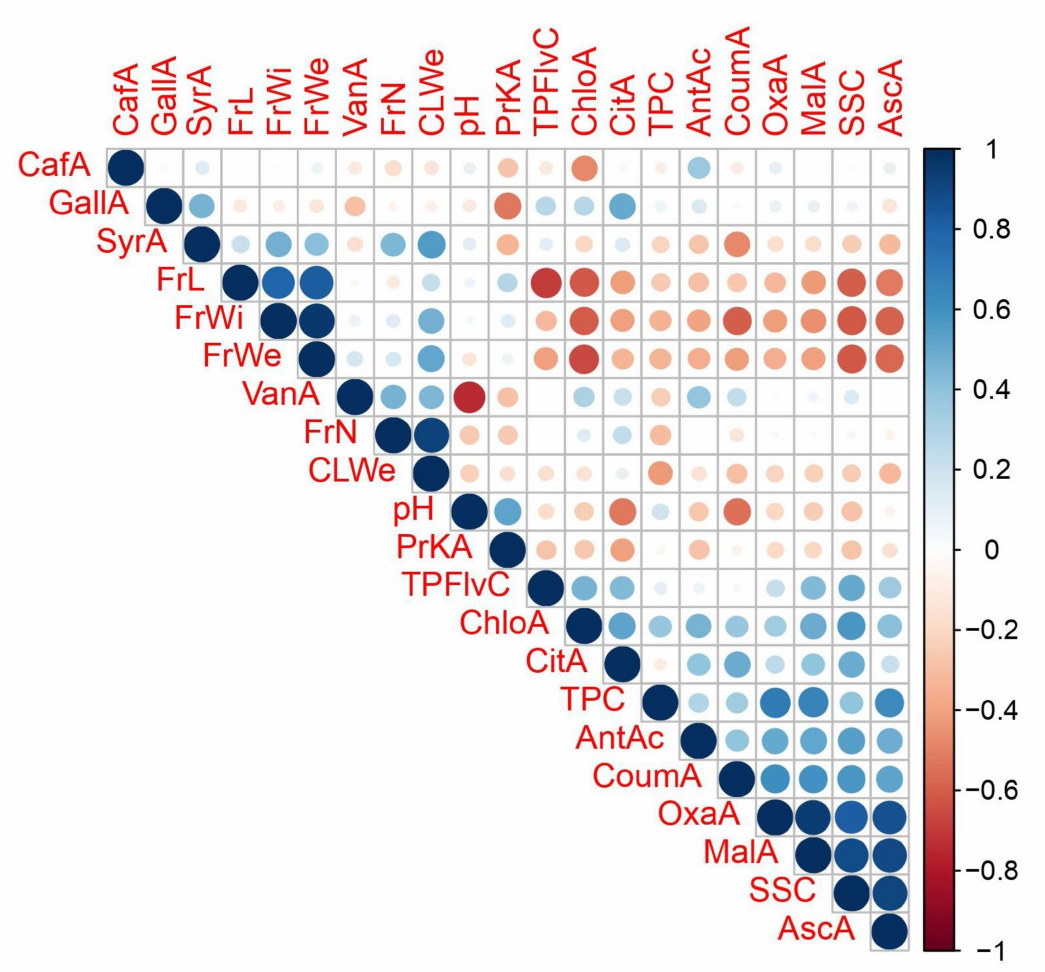
Figure 3. Pearson correlation coefficients among characteristics (Blue color represents a positive correlation and higher darkness and larger circles means stronger positive correlation; the same applies in red but red represents negative